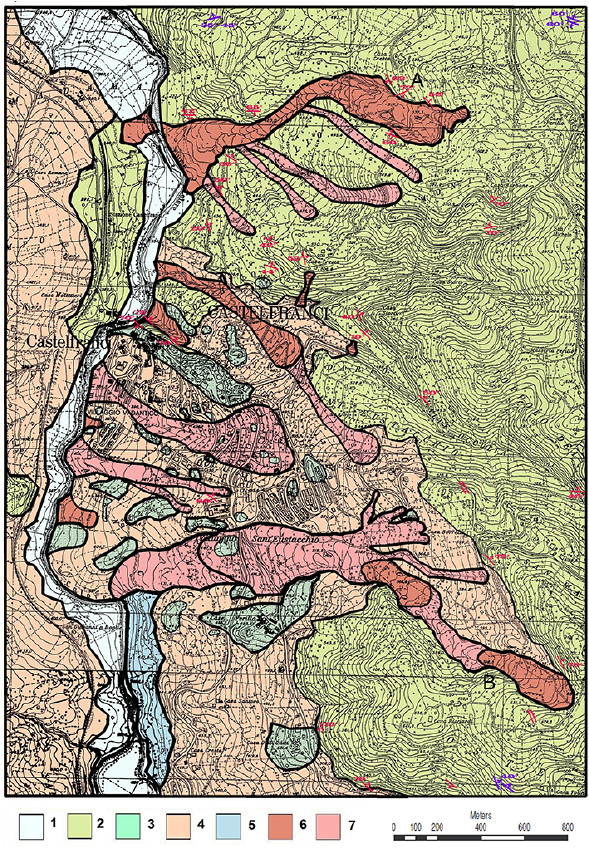
Fig. 1a. Landslide and geological map of Castelfranci municipality (modified after Peluso, 1999). Legend: (1) recent alluvial deposits; (2) sandstone complex; (3) wildflysch olistostromes; (4) clay com- plex; (5) conglomerates; (6) active landslide; (7) dormant landslide. The two major landslides in the area are indicated (A is the Chian- iello landslide, B the Lago